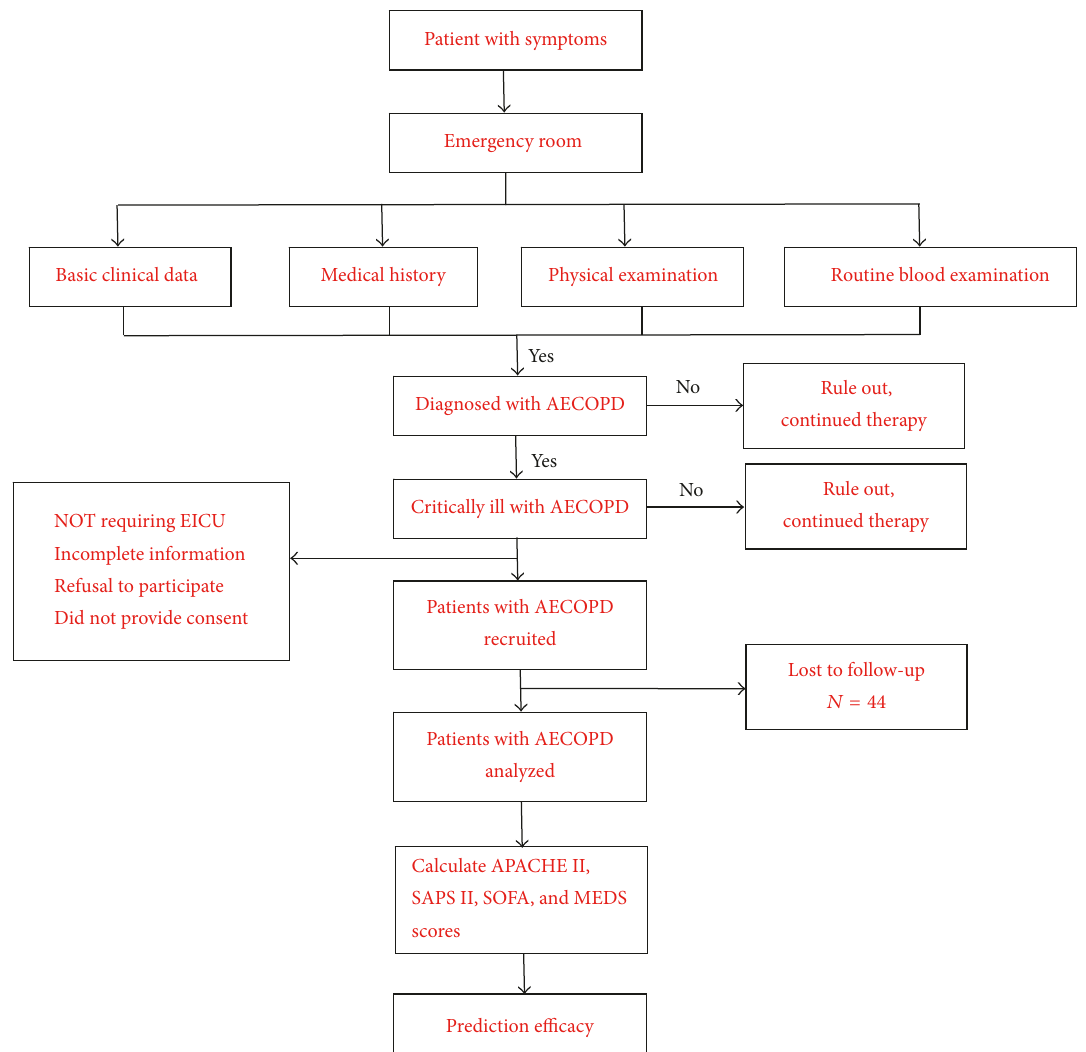
Figure 1: Flow chart of inclusion and recruitment workup (APACHE II: Acute Physiology and Chronic Health Evaluation; SAPS II: the Simplified Acute Physiology Score II; SOFA: Sepsis-Related Organ Failure Assessment; MEDS: mortality in emergency department